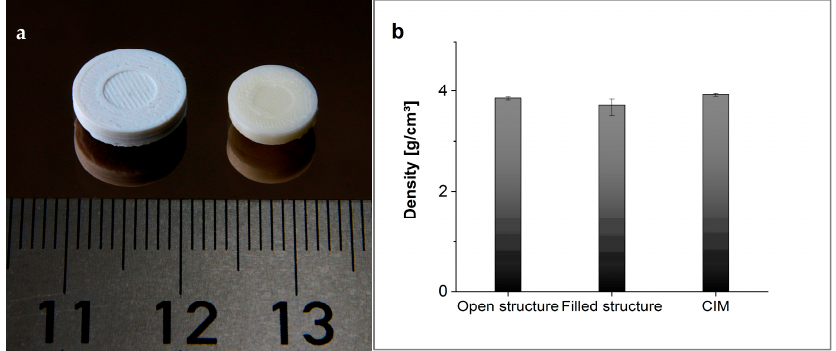
Figure 9. ( a ) Test disk and ( b ) density of different samples.